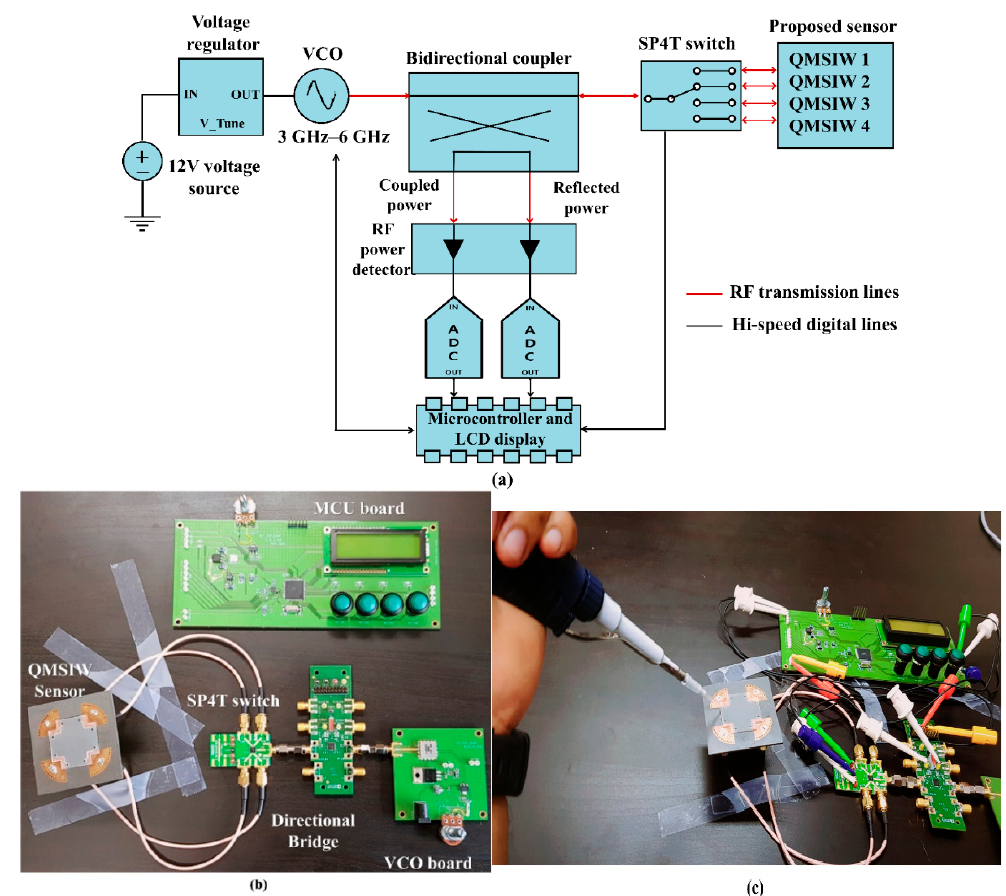
Figure 8. The proposed built-in system to determine unknown dielectric constant: ( a ) block diagram. The radio frequency (RF) power detector measures the power amplitude, and the micro-control unit (MCU) determines resonance frequency corresponding to peak S 11 amplitude internal algorithm settings, ( b ) prototype circuit modules, and ( c ) measurement setup.